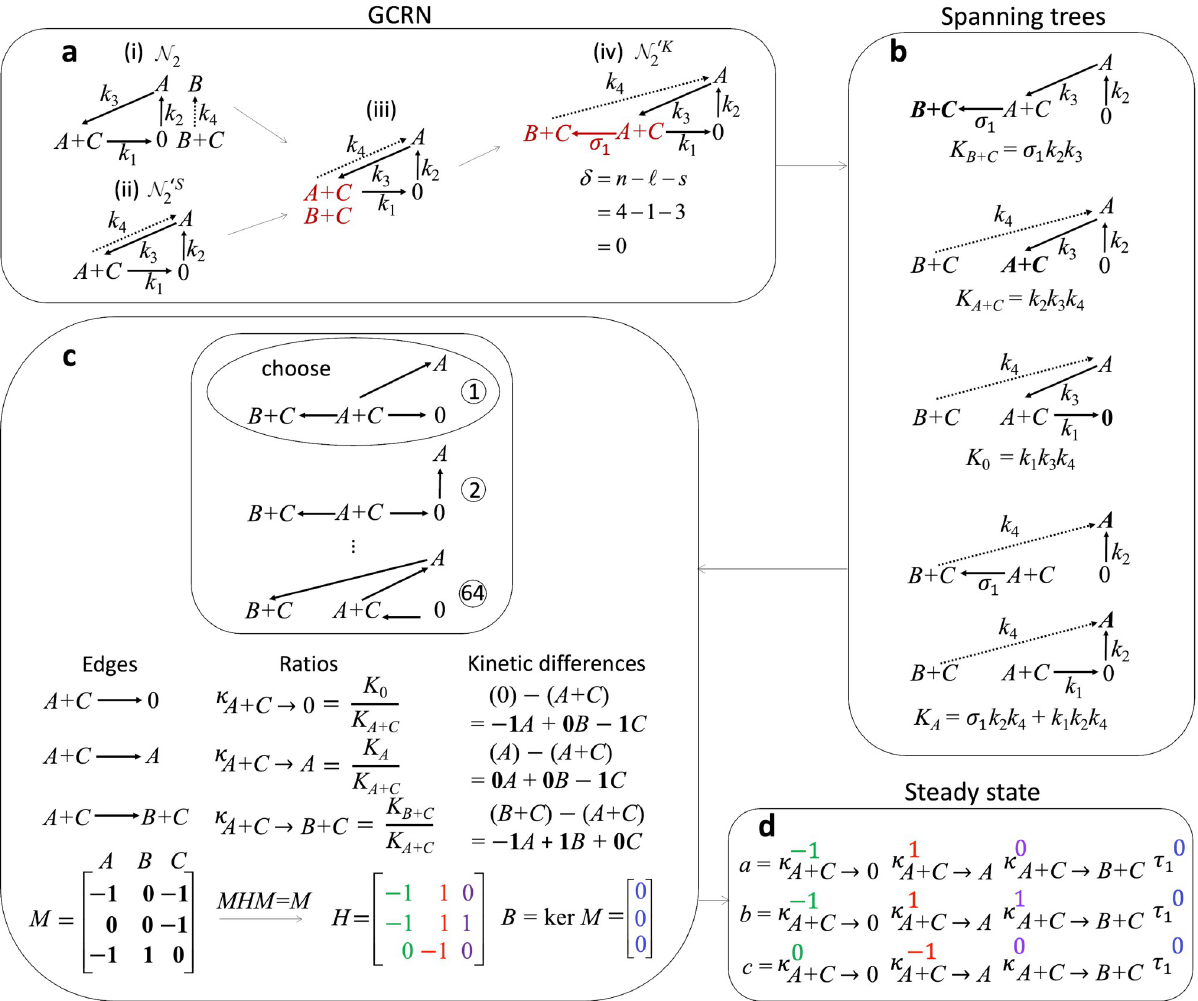
Fig 2. Derivation of analytic steady state via network translation. a The kinetic-order CRN N 0 K is constructed from the edges of the stoichiometric 2 CRN N 0 S but the nodes are the source nodes of the associated reactions in the original network N . For instance, the edges associated with k 1 and k 4 in 2 2 (ii) have corresponding source nodes A + C and B + C , respectively, in the original network (i). Since there are two source nodes ( A + C and B + C ) N 0 K 2 which share a single node in (iii), a phantom edge with a zero stoichiometric vector and a free parameter rate constant ( σ 1 ) is introduced (upper right). Notice that this operation maintains the dynamics of the original network. Proceed to the next step since the deficiency of N 0 K is zero (i.e., KDZ). b 2 Collect all the spanning trees of N 0 K (i.e., connected subgraphs of the N 0 K without a cycle) which direct towards each node ( B + C , A + C , 0, and A ). 2 2 Then multiply the rate constants associated with the edges of each spanning tree. For instance, the products of the rate constants associated with the edges of the two spanning trees towards node A are σ 1 k 2 k 4 and k 1 k 2 k 4 (bottom). Compute each tree constant ( K ) by adding the product of the rate i constants over all the spanning trees towards node ( i ). Hence, the tree constant K A = σ 1 k 2 k 4 + k 1 k 2 k 4 is obtained. c Choose an arbitrary tree (i.e., a connected graph without a cycle) containing all the nodes in N 0 K , which is not necessarily its subgraph. Then, for each edge ( i ! i 0 ) of the chosen tree, � � 2 K i 0 and the kinetic difference ( i 0 − i ) (middle). For instance, the edge A + C ! 0 has the ratio of the tree ¼ find the ratios of the tree constants k i ! i 0 K i K 0 constants k ¼ and kinetic difference (0) − ( A + C ) = − 1 A + 0 B − 1 C . From the kinetic differences, construct the matrix M (bottom) by listing A þ C ! 0 K A þ C in each row the coefficients in the kinetic difference associated with an edge of the tree. Hence, the coefficients in the kinetic difference − 1 A + 0 B − 1 C are the entries of the first row of M (i.e., [ − 1, 0, − 1]). Then, compute a generalized inverse H of M (i.e., MHM = M ) and the kernel B of M . d Derive the analytic steady state of the network from the ratio of the tree constants κ i ! i 0 and the matrices H and B . Specifically, raise the ratios of the tree constants κ i ! i 0 in a component-wise manner to the entries of a row of H , and get their product. For instance, the ratio of the tree constants κ A + C ! 0 , κ A + C ! A , and k 1 k 0 . Meanwhile, one free parameter κ A + C ! B + C are raised to the entries in the first row of H ( − 1, 1 and 0, respectively). This gives k (cid:0) 1 A þ C ! 0 A þ C ! A A þ C ! B þ C ( τ 1 ) is introduced because the number of column of B is one. This τ 1 is raised to the entry of a row in B. Hence, t 0 is obtained. Finally, get the product 1 k (cid:0)